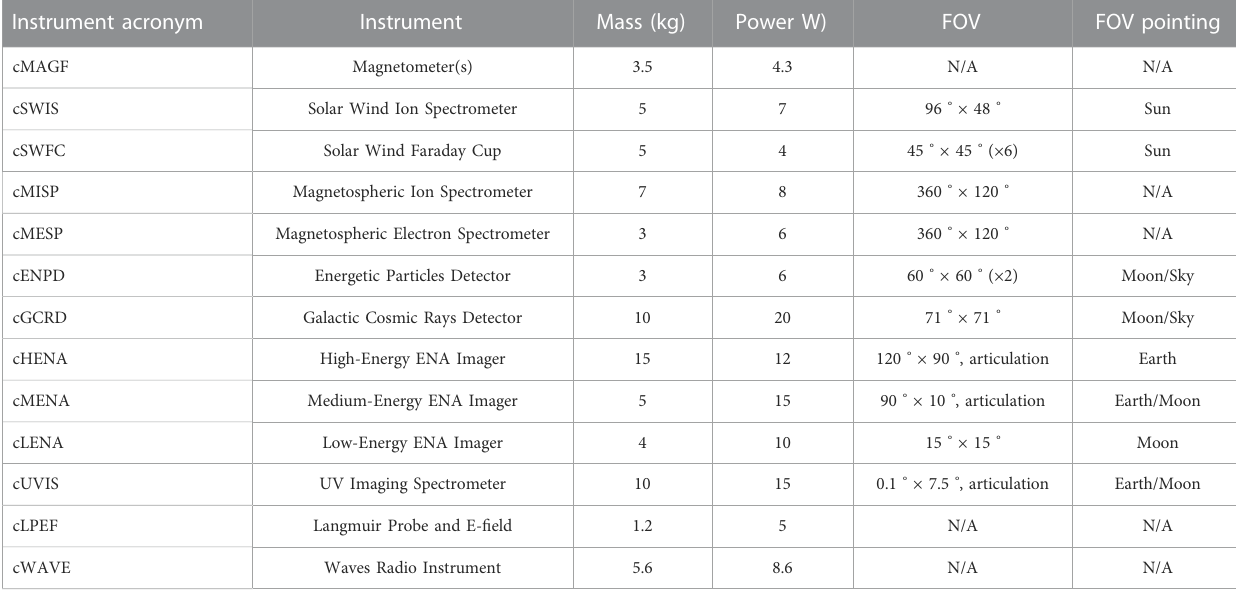
TABLE 5 SP4Gateway model payload instruments. Instrument